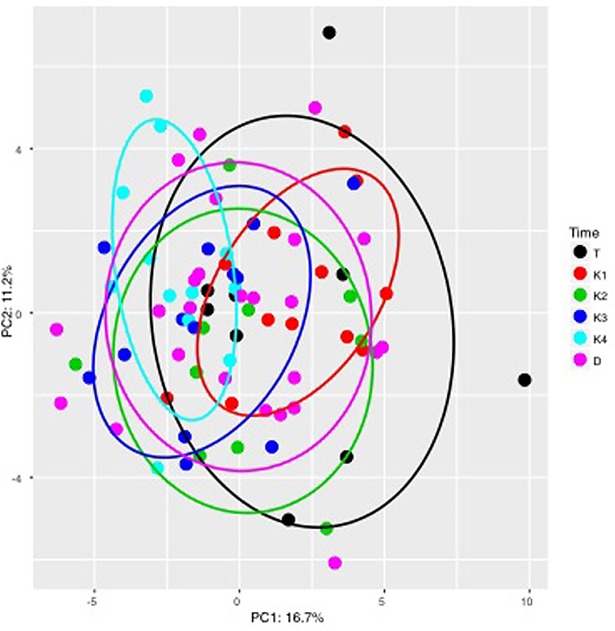
Scores for the first two principal component analysis (PCA) of fecal microbiota in donors at the beginning of the study and patients with irritable bowel syndrome after fecal microbiota transplantation (FMT, n = 13).Data have been centered within each donor series to remove donor differences for this analysis. Data are shown as donor (D: pink dots), FMT day (T: black dots), visit at week 1 (K1: red dots), visit at week 3 (K2: green dots), visit at week 12 (K3: dark blue dots) and visit at week 20/28 (K4: light blue dots). Each dot represents data from one patient for one visit. The first two PCs account for 27.9% (sum of PC1 and PC2) of the variation. The colored ellipses demonstrate the 68% confidence interval for PC1 and PC2. The PCA scores show that FMT seem to have an effect on the gut microbiota as systematic change is going forward.